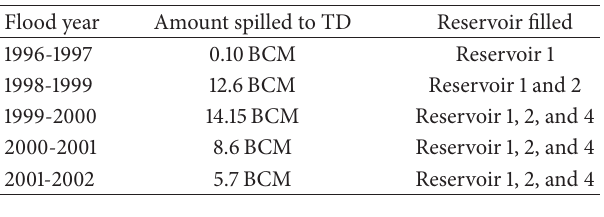
Table 1: TD conditions during the flood period 1996–2002.